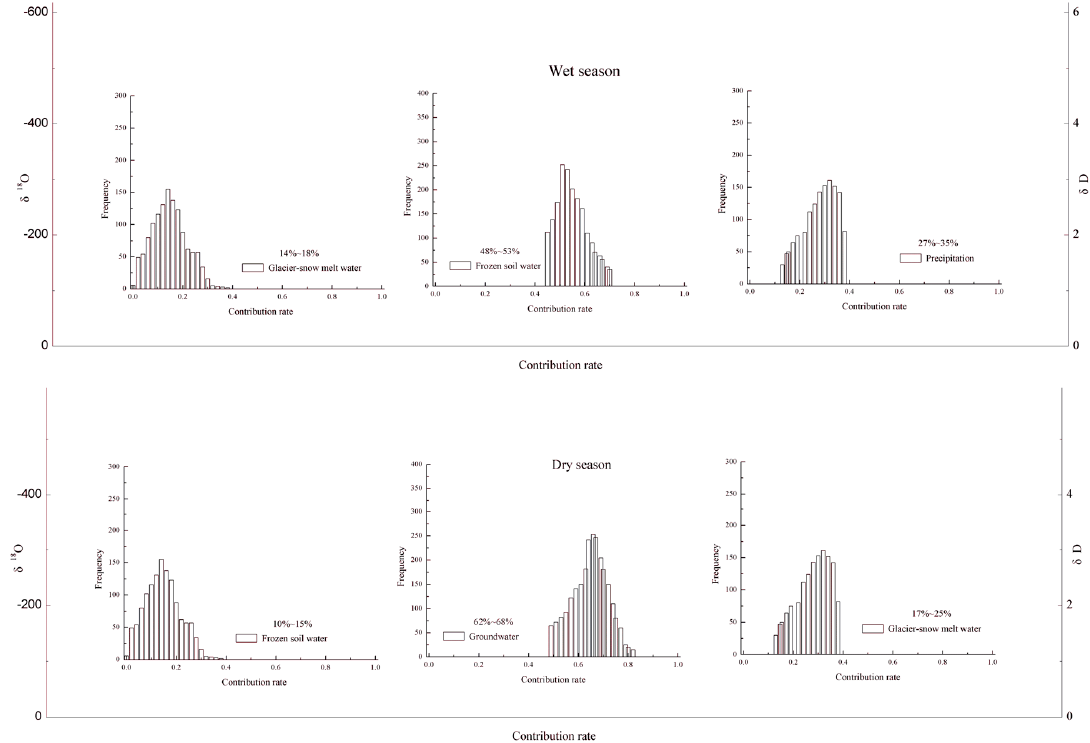
Figure 6 . The contributions of each end member to the runoff in the wet and dry season.